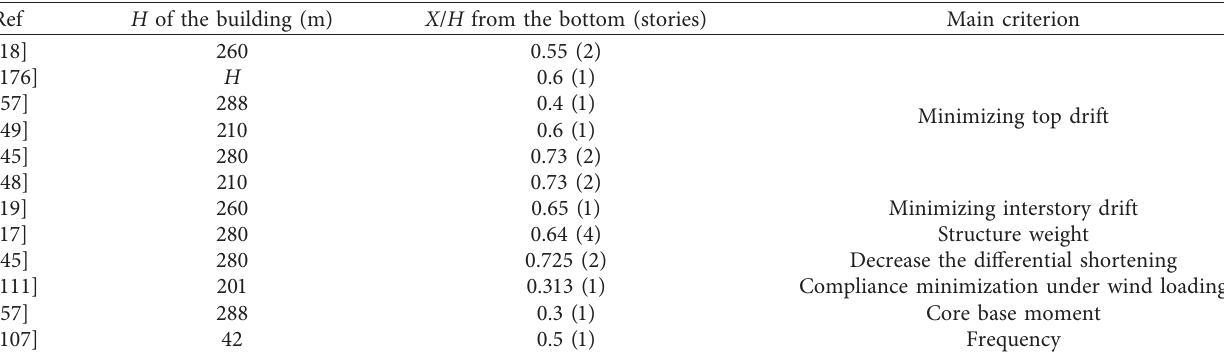
Table 1: RC core walls with one steel outrigger truss.